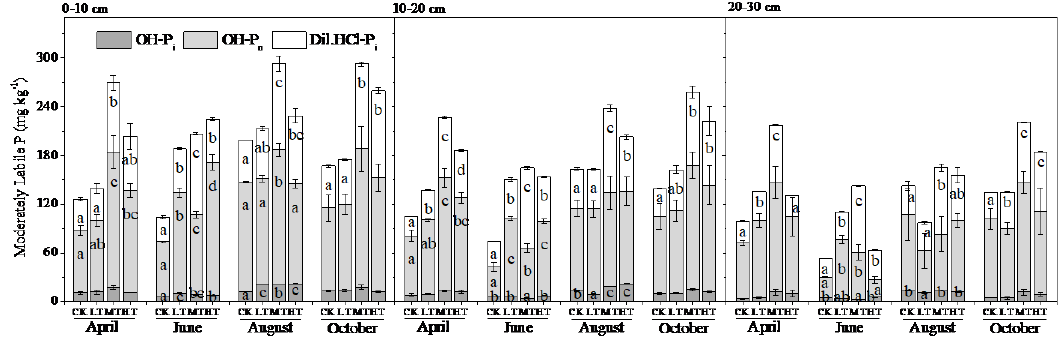
Figure 5. Response of moderately labile P fractions to thinning treatments at the three depths (0 −1 0, 10 −2 0 and 20 −3 0 cm) at various sampling times in L. principis-rupprechtii plantations. CK, control site; LT, light thinning; MT, moderate thinning; HT, high thinning. Error bars indicate standard error ( n = 3). Values within each sampling time followed by different letters differ significantly according to Tukey's test ( p <0.05). When the difference was not statistically significant, no letter notation was noted. Non-labile P concentration (42% – 77% of TP) was affected by thinning and season at all soil depths ( p <0.05, Table 3). Across treatments, non-labile P i and P o were higher in autumn and summer,